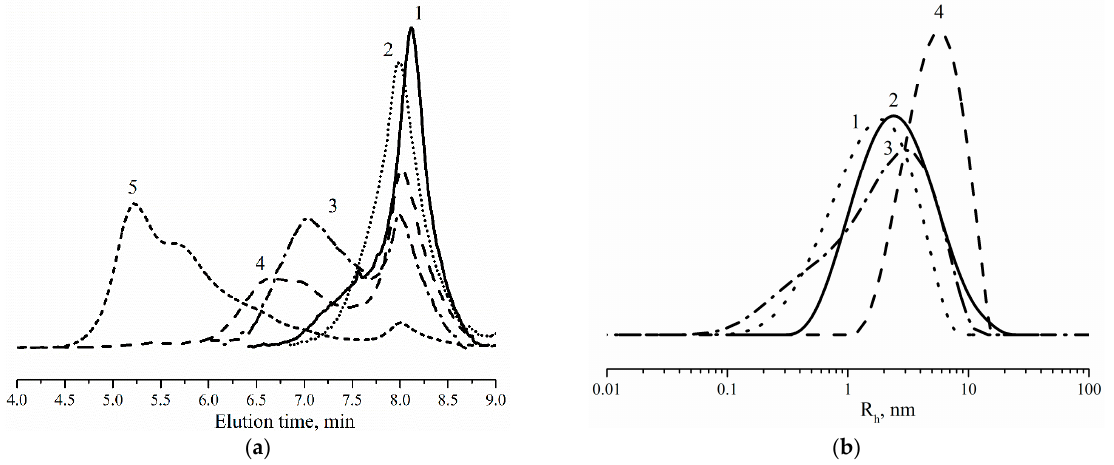
Figure 8. SEC profiles ( a ) and particle distribution ( b ) of hyperbranched polyurethane-triazoles obtained at [NCO] 0 /[OH] 0 as: 1.50 (1); 1.57 (2); 1.70 (3); 1.81 (4); 1.88 (5). Multimodal molecular weight distribution is due to the presence in the mixture of two ( AB 2 + B 4 , for samples 1–3) or three ( AB 2 + A 2 + B 4 , for samples 4–6) monomers at the